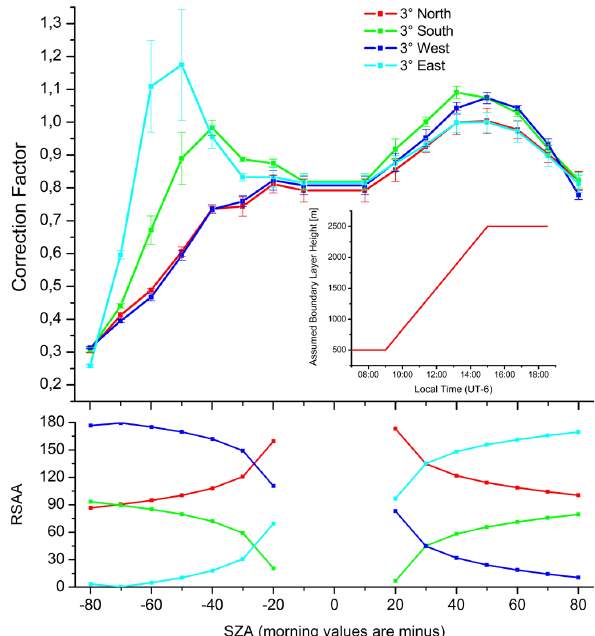
Fig. 6. Diurnal cycle of the correction factors (upper panel) consid- ering RSAA (lower panel) and a dynamic diurnal PBL typical for Mexico City (see inset) for four different directions perpendicular to each